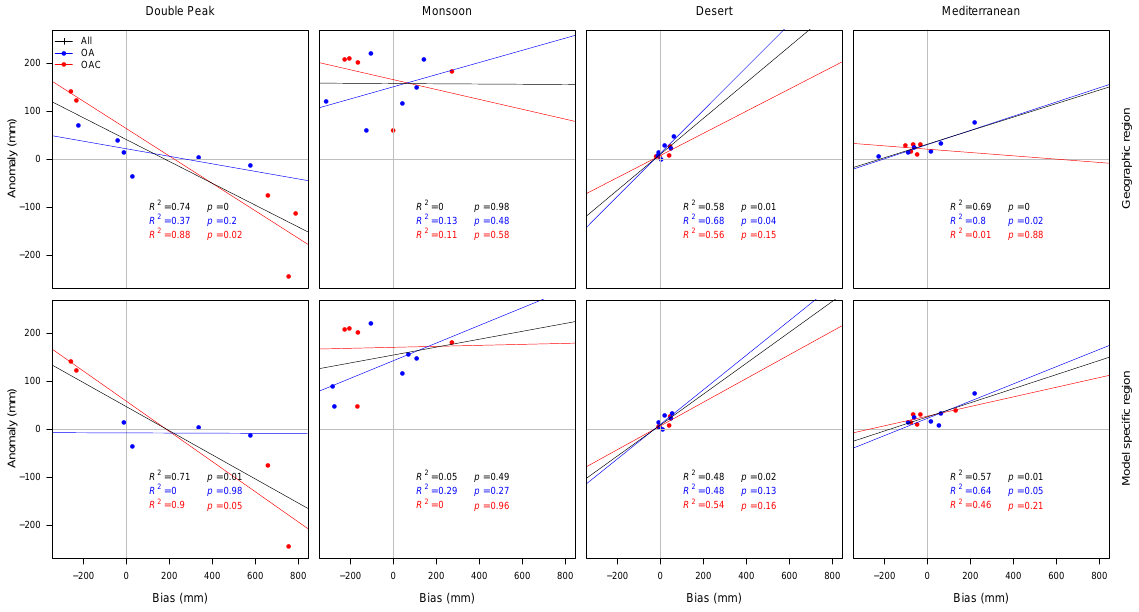
Fig. 7. Relationship between biases in the piControl simulation of mean annual precipitation (mm) and mid-Holocene precipitation anomalies ( midHolocene − piControl ) as simulated by each of the CMIP5 models for each of the precipitation regimes (Double Peak, Monsoon, Desert, Mediterranean). The upper panels show biases and anomalies calculated for specific latitudinal bands as defined from the modern observed spatial extent of each regime (geographic region). The lower panels show biases and anomalies calculated for the region identified as characterized by a given regime in each model and simulation (model specific region). The regressions are calculated for all models (All: black), for the coupled ocean–atmosphere models (OA: blue) and for the carbon-cycle models (OAC: